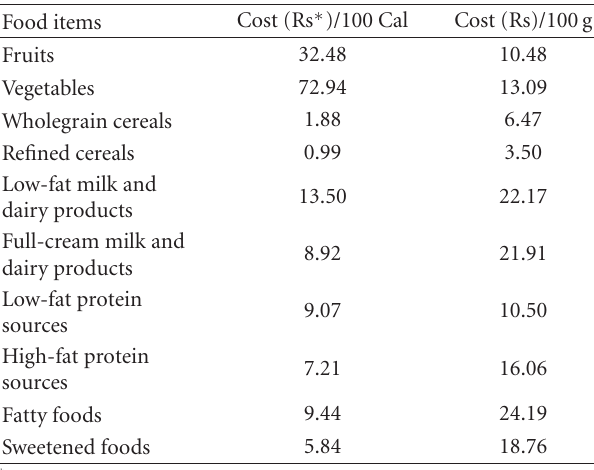
Table 4: Cost of food items per 100 Cal and per 100 g. Table 5: Physical activity level of low and high socioeconomic